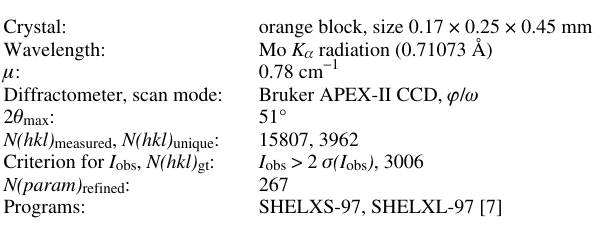
Table 1. Data collection and handling.